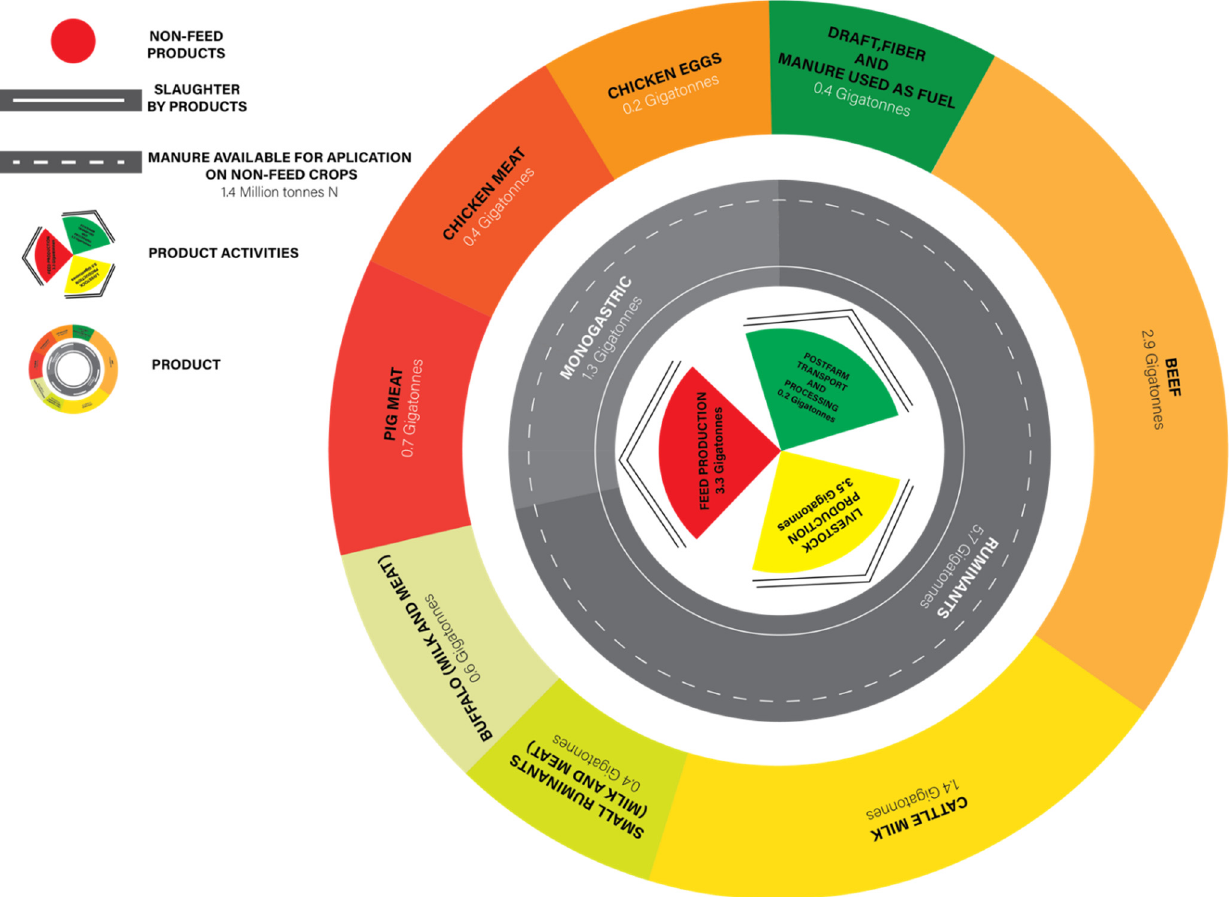
Figure 1. Global livestock emissions from supply chains, production activities, and products (adapted from [1]). This figure is excluded from the CC BY licence under which this article is pub- lished.